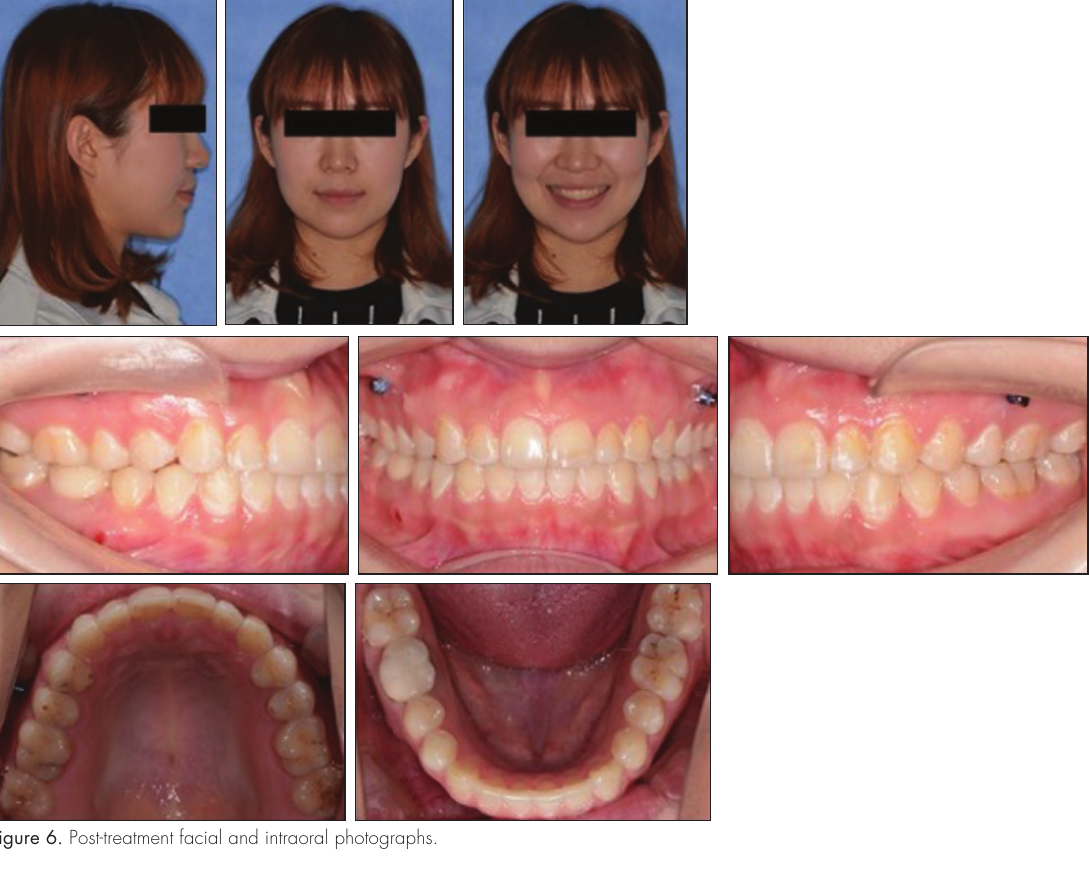
Figure 6. Post-treatment facial and intraoral photographs.